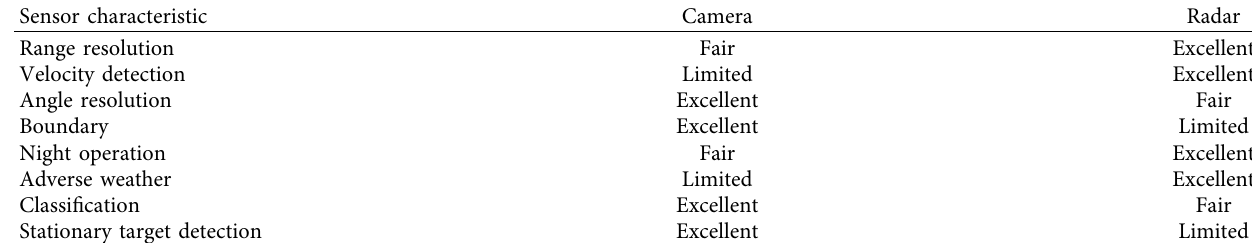
Figure 5: Schematic diagram of radar installation position. Table 3: A comparison of camera and radar sensors